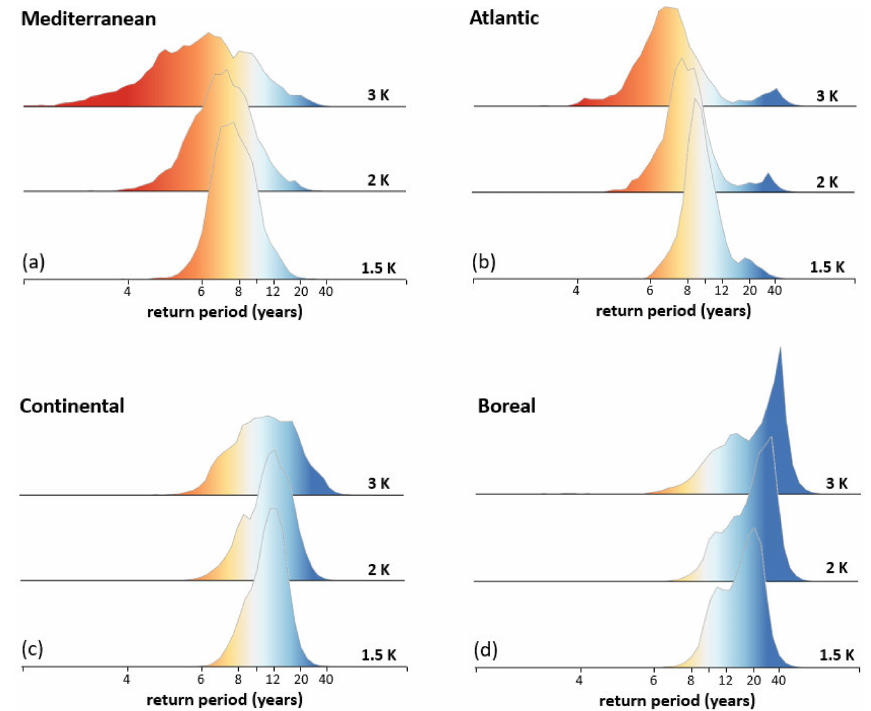
Figure 3. Frequency distribution of the return period (years) for different GWLs corresponding to an event with a return period of 10 years in the reference baseline for the sub-regions: (a) Mediterranean, (b) Atlantic, (c) Continental, and (d) Boreal. Values lower (higher) than 10 represent an increase (reduction) in drought frequency. The vertical grey lines demark the 10-year return period, and the tick marks are uniformly spaced in